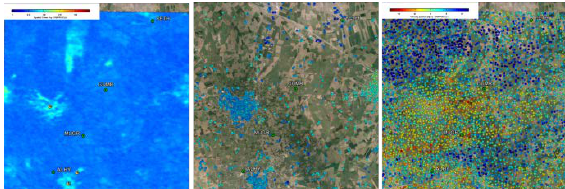
Figure 7. Average spatial coherence (left) and differences between processing approaches: PS InSAR (middle) and Quasi PS InSAR (right) over Cumra area from ERS